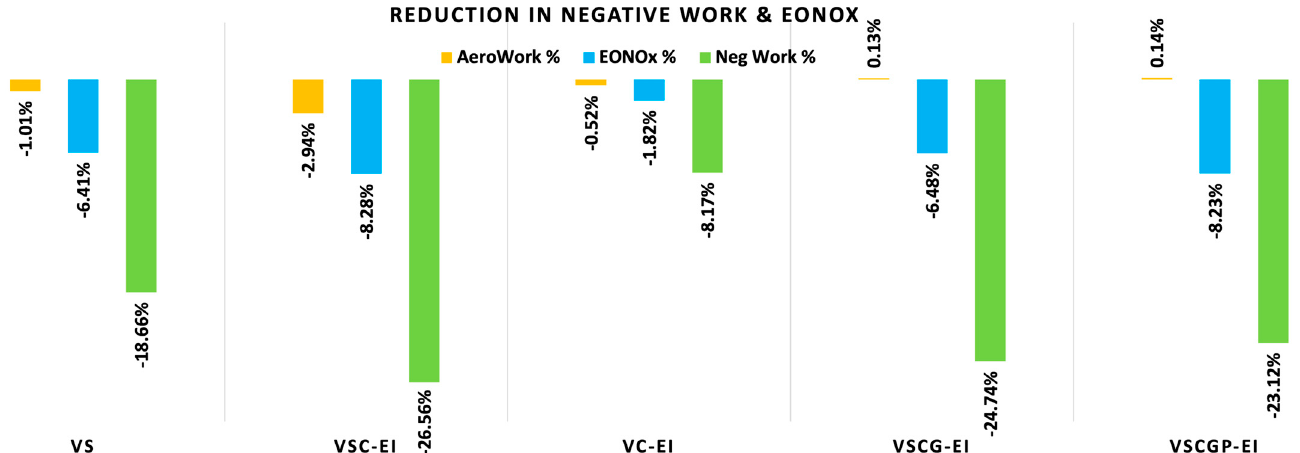
Figure 9. Reduction in aerodynamic work along with associated EONOx reduction. The last bar plot shows the reduction in negative work which includes engine braking, motoring losses and service braking.